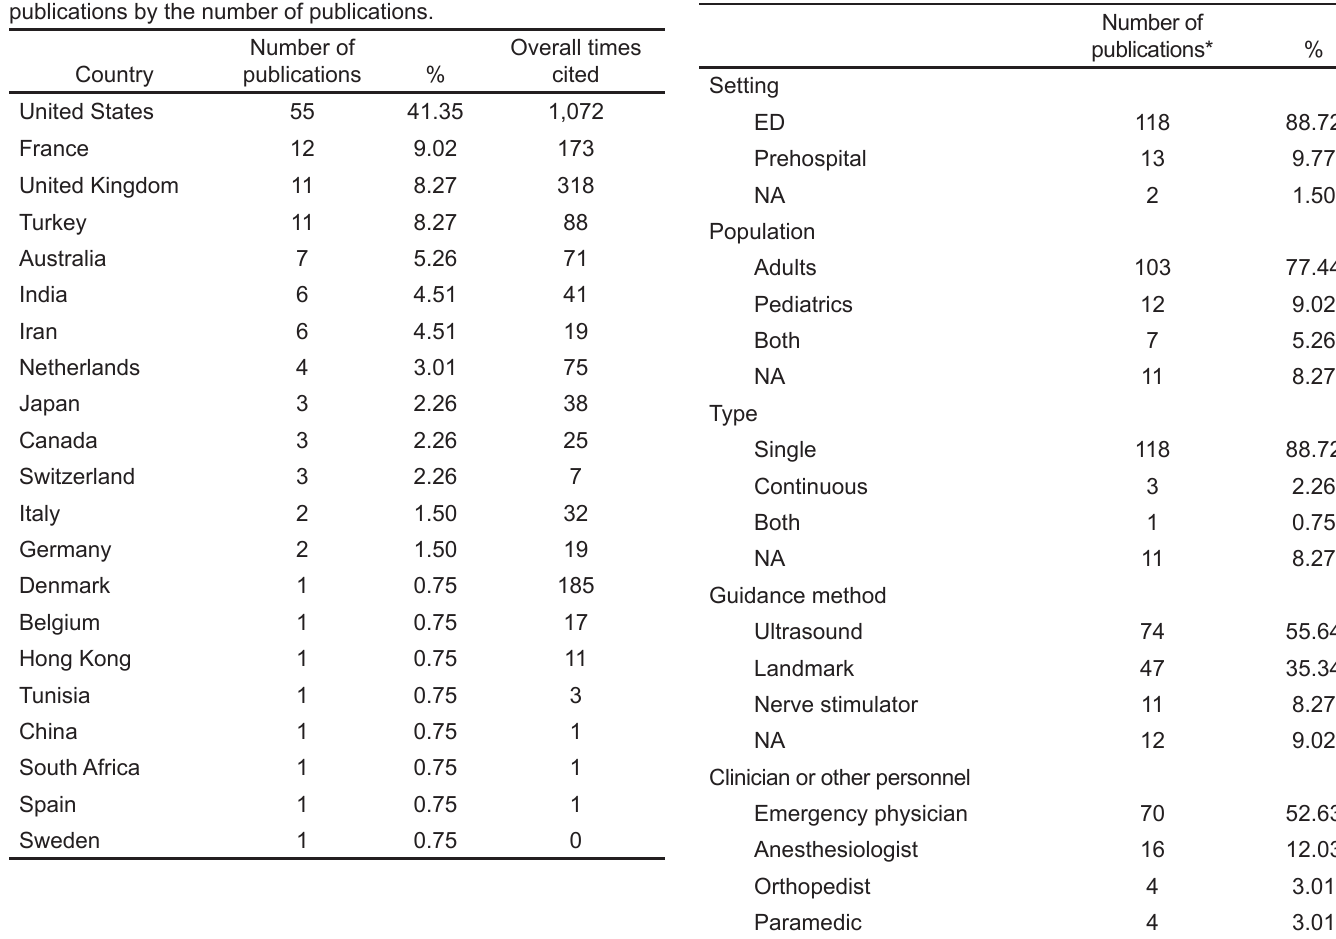
Table 2. Characteristics of regional anesthesia-related